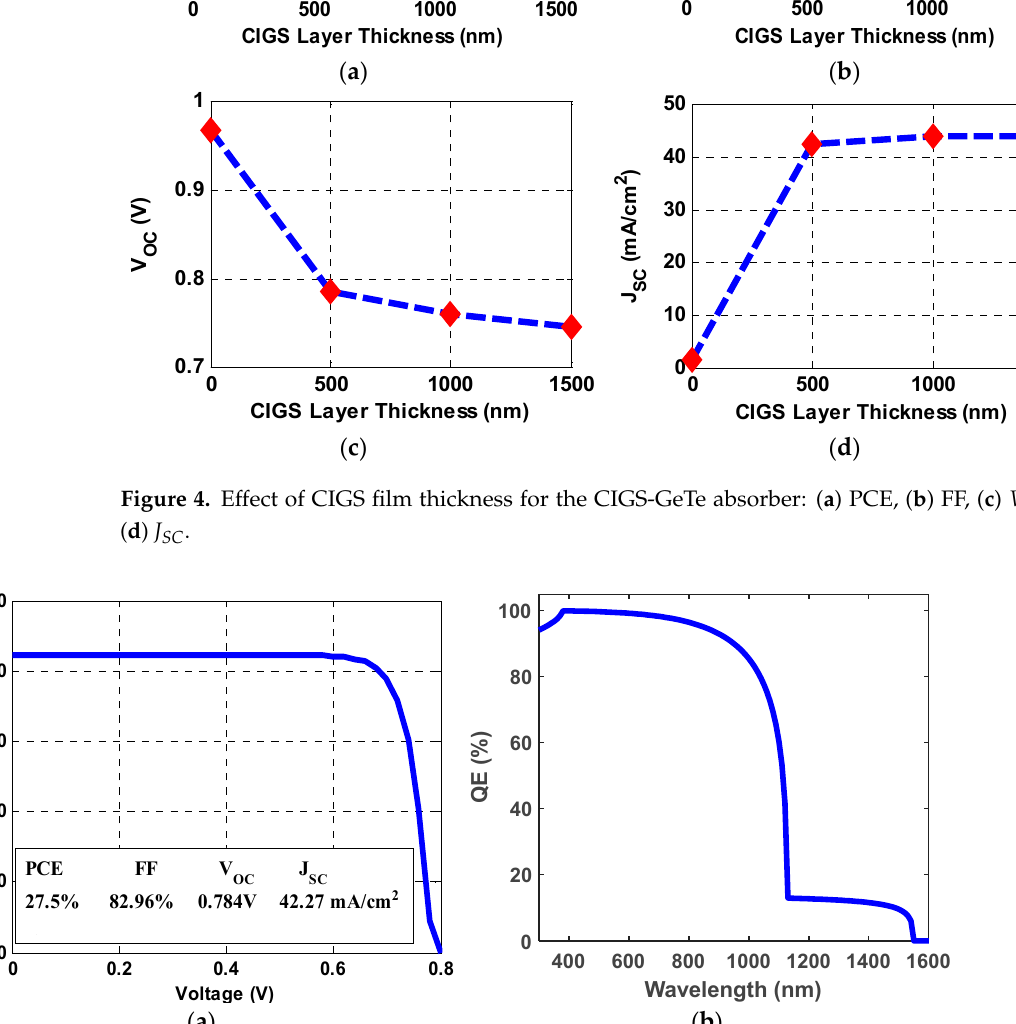
Figure 5. ( a ) CIGS-GeTe solar cell outputs and its JV curve and ( b ) EQE curve.